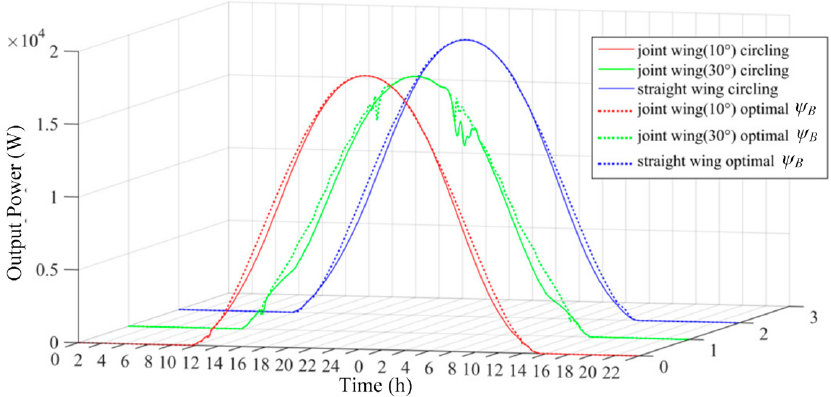
Figure 19. Output power of different configurations with different flight strategies. Table 4. Energy acquisition of different configurations with different flight